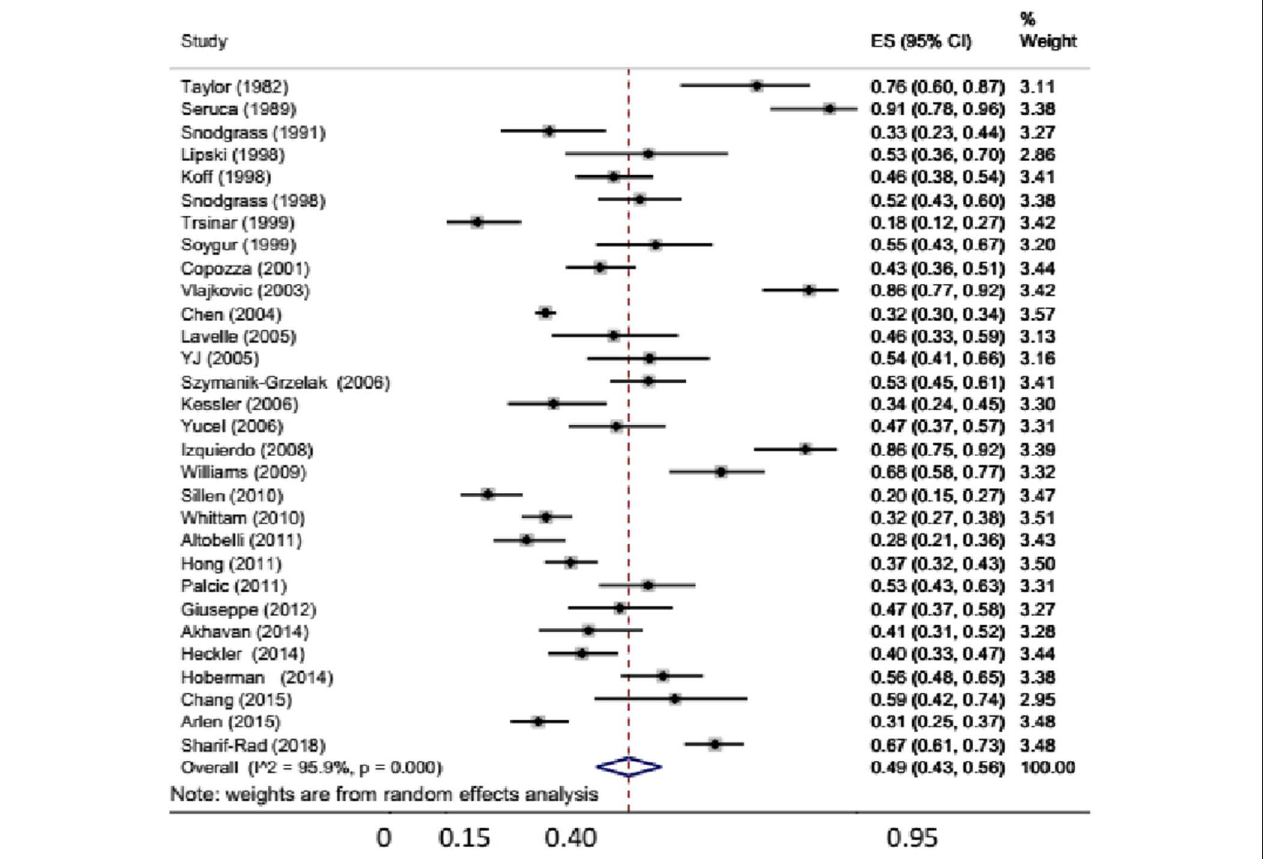
FIGURE 3 | Prevalence of bladder dysfunction in children with primary vesicoureteral reflux